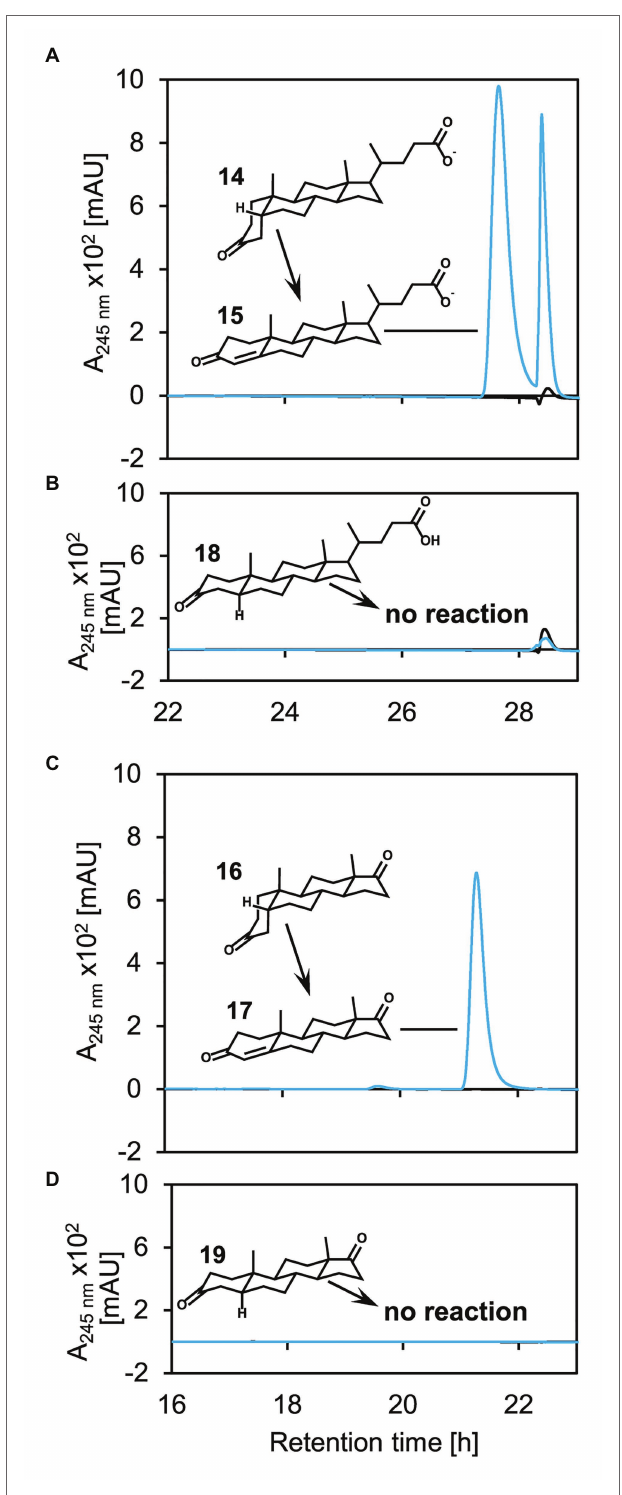
FIGURE 5 | Catalytic activity of 5 β - Δ 4 -KSTD1 toward different steroids with ( A + B ) or without ( C + D ) side chain and 5 β ‐ ( A + C ) or 5 α ‐ ( B + D ) structure. UV chromatograms of enzyme assays with 5 β - Δ 4 -KSTD1, K 3 Fe(CN) 6 as electron acceptor and 5 β -3-ketolithocholate ( 14 , A ), 5 α -3-ketolithocholate ( 18 , B